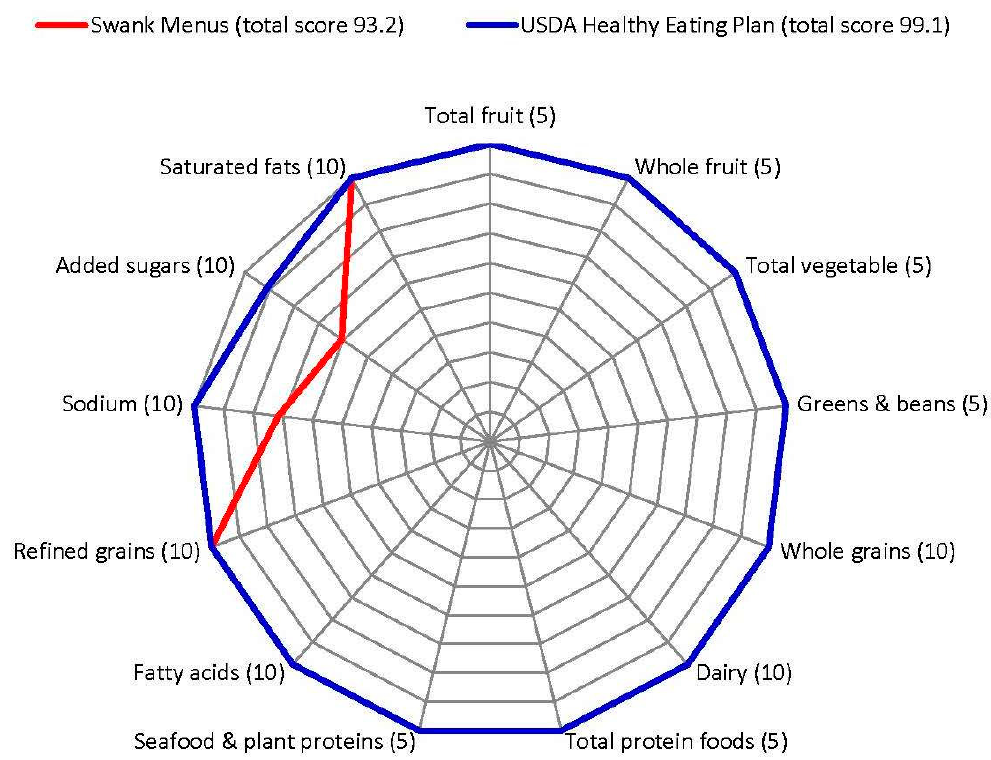
Figure 1. Healthy Eating Index-2015 component scores for seven-day low saturated fat Swank and seven-day USDA Healthy US-Style Eating Pattern menus [71] calculated using the population ratio method. Values in parentheses indicate maximum score for each component. Component scores are plotted on each axis as a percentage of the maximum score and connected with lines. The outermost ring represents a perfect score.